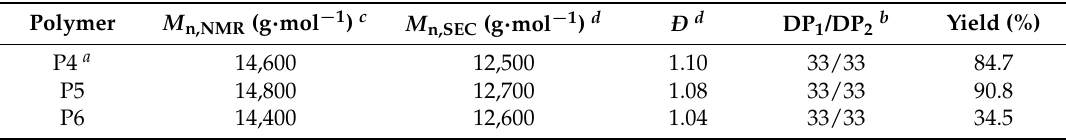
Table 2. Characteristics of P4 , P5 , and P6